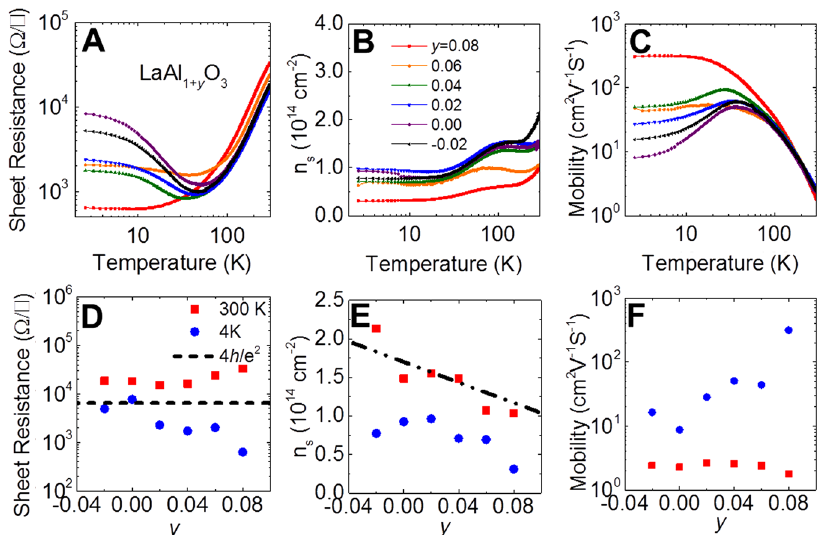
Fig. 5 a Sheet resistance, b carrier density, and c hall mobility as functions of temperature for a series of 10 unit-cell LaAl 1+ y O 3(1+0.5 y ) fi lms with different y values. d Sheet resistance, e sheet carrier density, and f hall mobility as functions of fi lm stoichiometry at 300 K ( red squares ) and 4 K ( blue dots ). The dashed line in d is the quantum resistance limit h /4e 2 . 38 The dashed line in e indicates the theoretical value of sheet carrier density for 10 unit-cell fi lms with different stoichiometry under the assumption of pure electronic reconstruction.